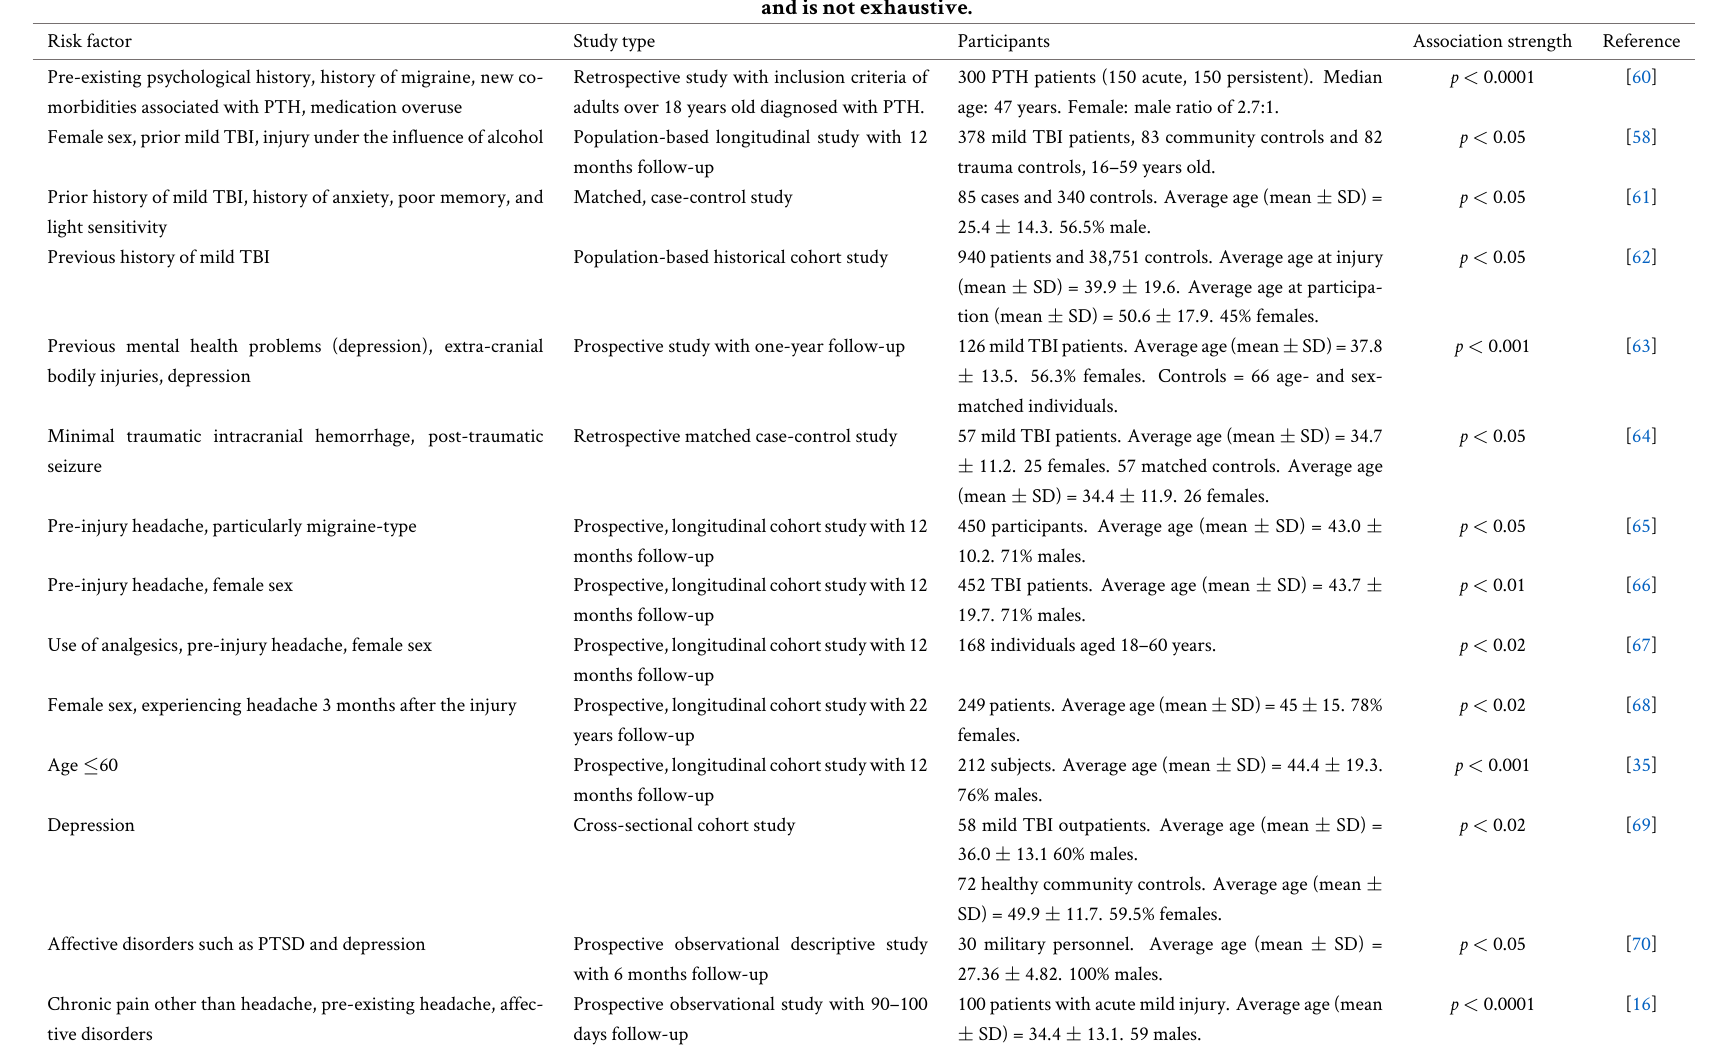
Table 1. A summary of different studies investigating risk factors associated with PTH. The table provides an overview of the most significant risk factors associated with PTH and is not